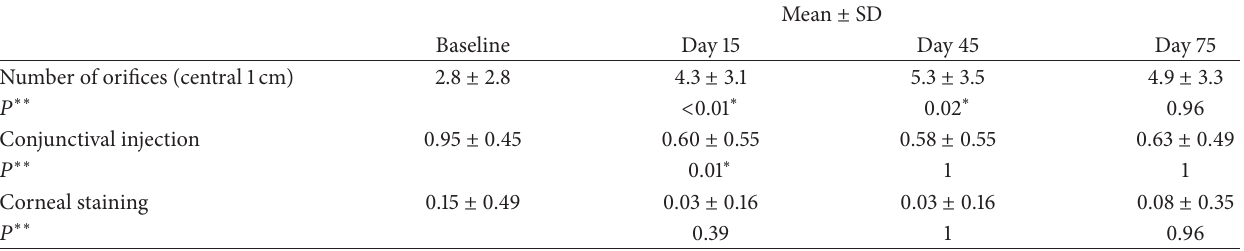
Table 3: Evaluation of number of orifices within central 1cm, conjunctival injection, and corneal staining changes during IPL treatments.